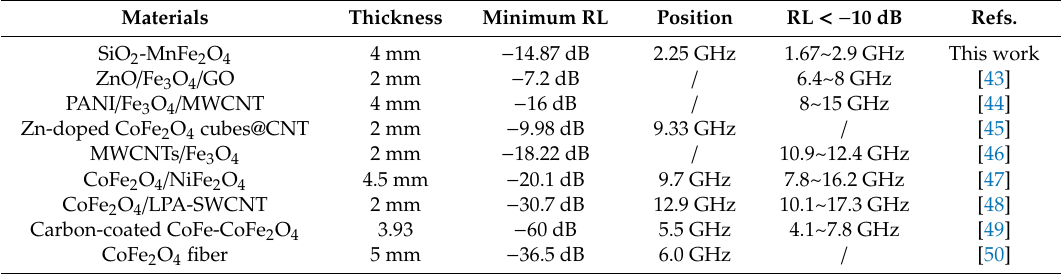
Table 1. Comparison of microwave absorbing properties between SiO 2 -MnFe 2 O 4 composite and other materials available in the